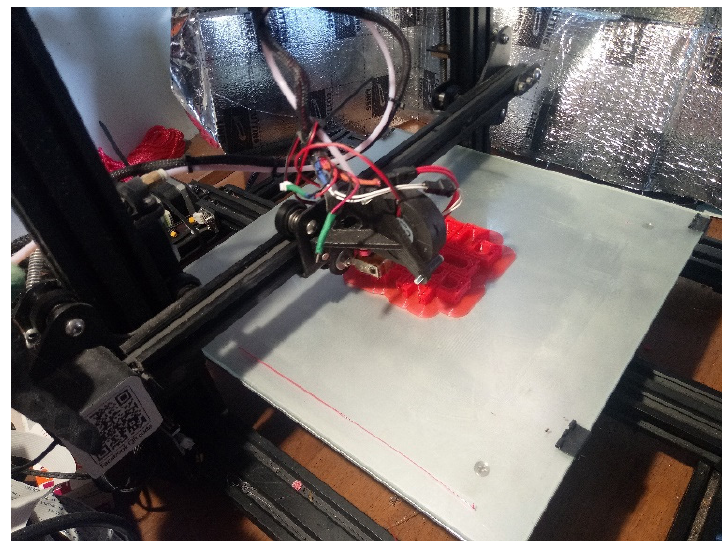
Figure 2. Typical FDM printer during operation. The heated nozzle deposits the material (red) and places it layer by layer on the print bed in the required shape.